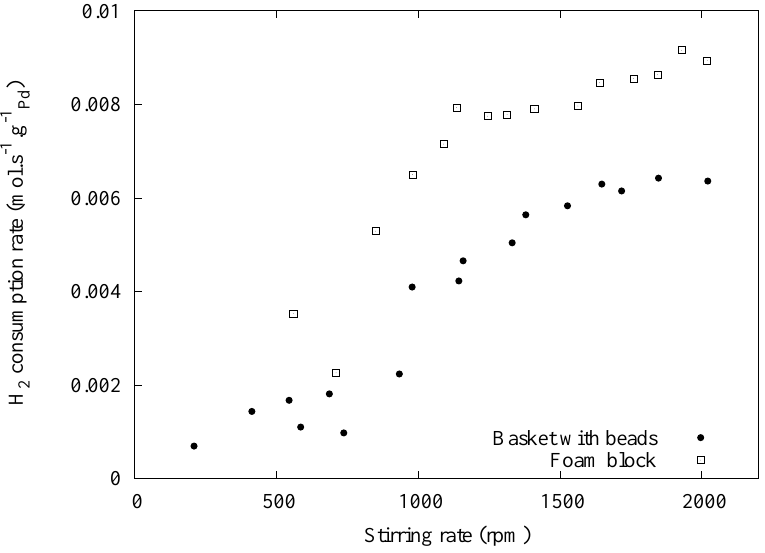
Figure 3. Hydrogen consumption rate per gram of Pd in α -methylstyrene hydrogenation—comparison between the basket with 2 mm beads and the 40 PPI (pores per inch) foam